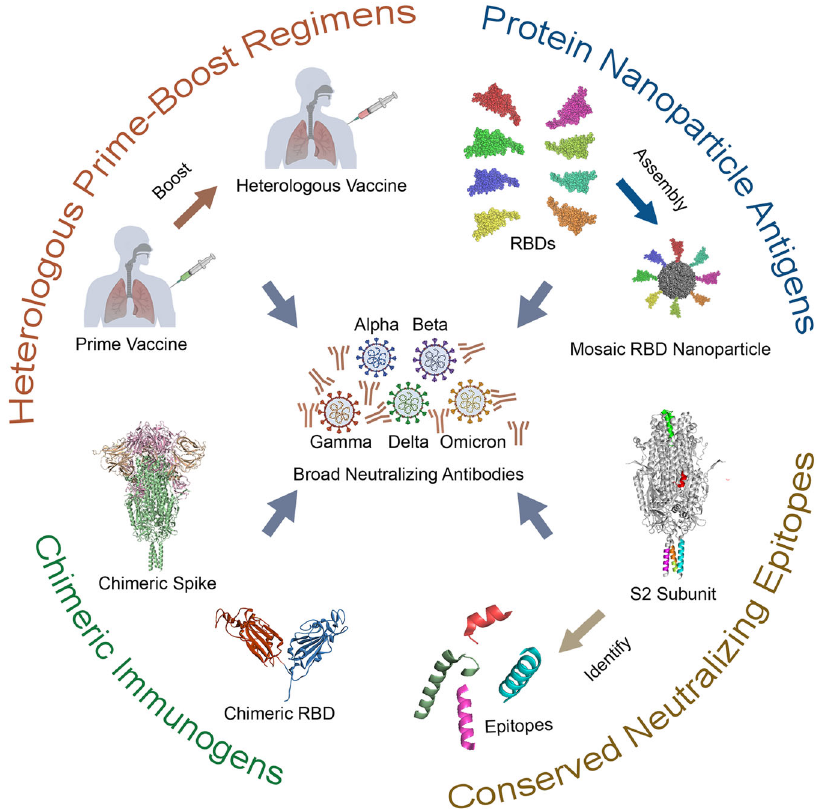
Fig. 6 Four strategies in SARS-CoV-2 universal vaccine design. They are heterologous prime-boost vaccination regimens, construction of protein nanoparticle antigens, design of chimeric immunogens, and utilization of conserved neutralizing